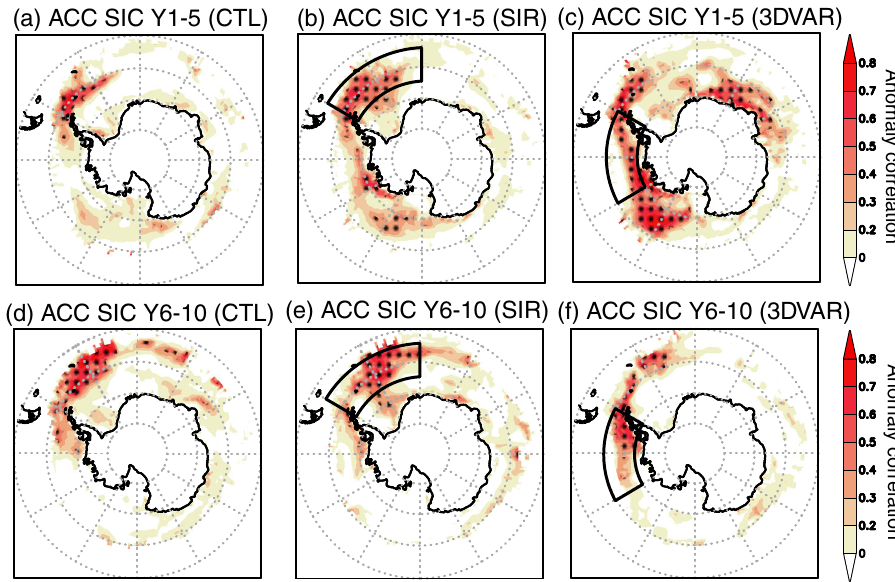
Fig. 1 Prediction skills of decadal sea ice concentration (SIC) variability in the Antarctic seas. a Anomaly correlation (ACC) of the 5-yr mean SIC anomalies between the observation and the CTL experiment for the lead times of 1 – 5 years. Black dots indicate positive ACCs which are statistically signi fi cant at 90% con fi dence level using Student ’ s t test. b , c Same as in a , but for the ACC from the SIR and 3DVAR experiments. Curved boxes indicate the Weddell Sea (Wed; 60° − 0°W, 65° − 55°S) and the Amundsen – Bellingshausen Sea (120° − 60°W, 70° − 60°S) with signi fi cantly high ACC. d – f